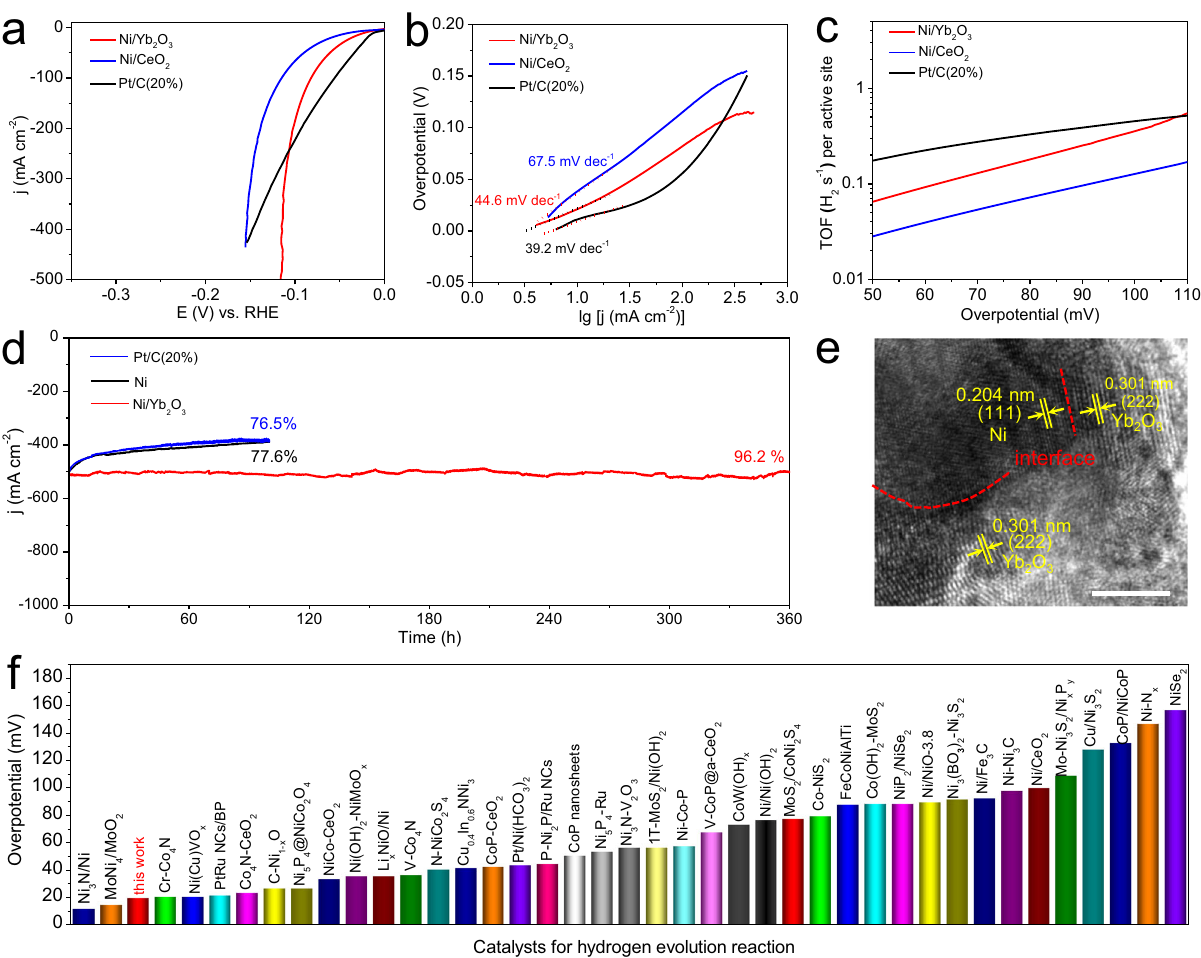
Fig. 5 Electrocatalytic HER activity and stability for Ni/Yb 2 O 3 electrode in 1.0 M KOH. a Polarization curves (scan rate: 5 mV s − 1 ) of Ni/Yb 2 O 3 , Ni/ CeO 2 , and Pt/C(20%) electrodes with a mass loading of ca. 3.5 mg cm − 2 . b Tafel plots derived from the curves in ( a ). c TOF values of Ni/Yb 2 O 3 , Ni/CeO 2 , and Pt/C(20%) electrodes. d Chronopotentionmetric curves of Ni/Yb 2 O 3 , Ni, and Pt/C(20%) electrodes at the overpotential of 116.0, 305.0, and 167.0 mV, respectively. e TEM image of Ni/Yb 2 O 3 after the HER test. f Comparison of the HER activities for Ni/Yb 2 O 3 and the reported electrocatalysts (Supplementary Table